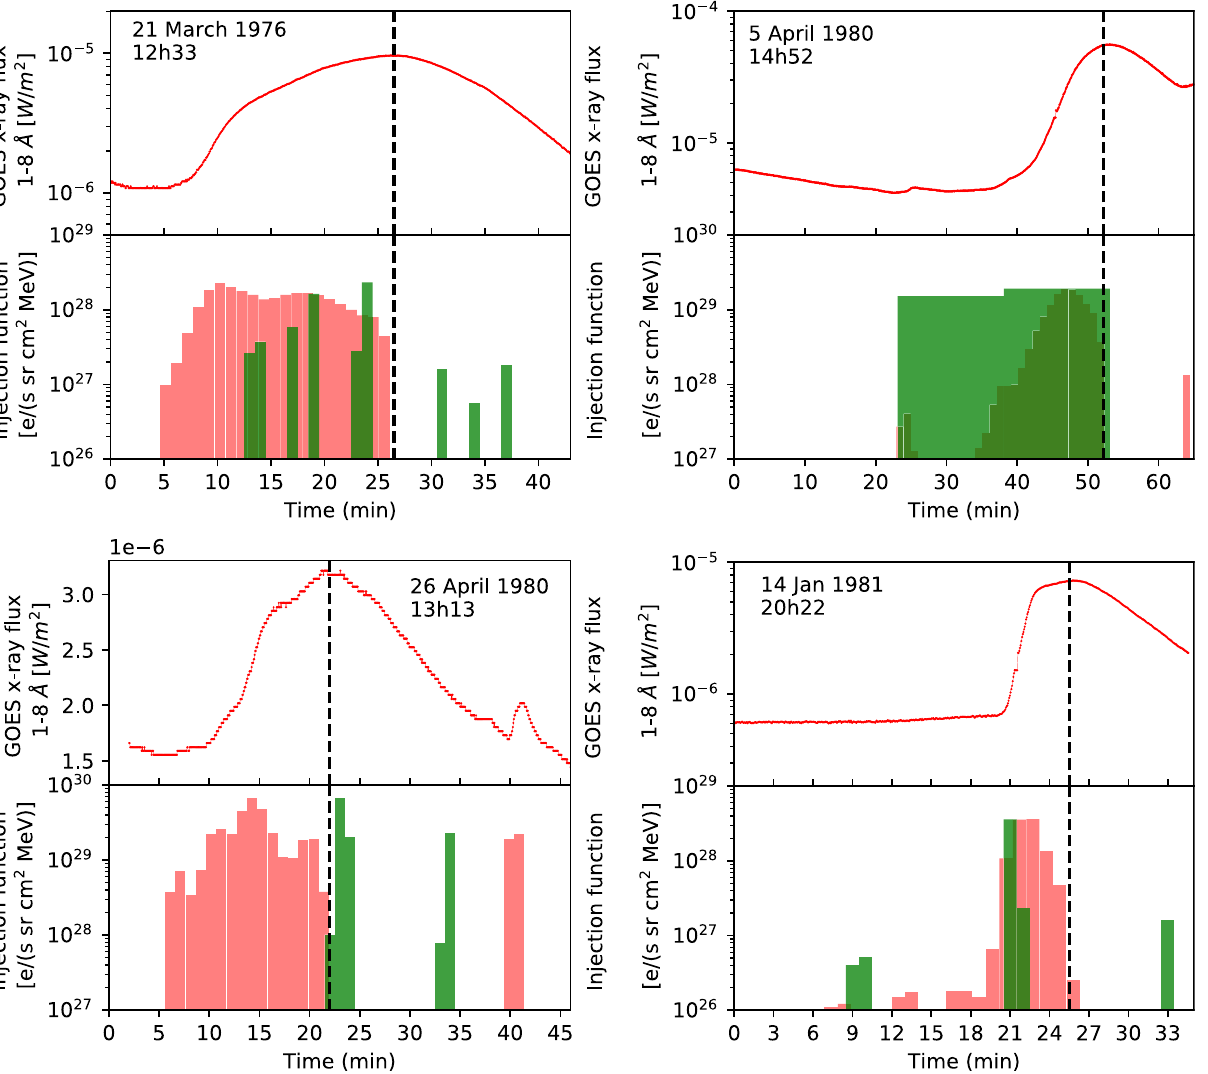
Fig. B.1. GOES-3 SXR fl ux (top panels), the time derivative of the SXR fl ux (red bars), and the results of Pacheco et al. (2019) (green bars) for short duration events. The time in each plot is solar